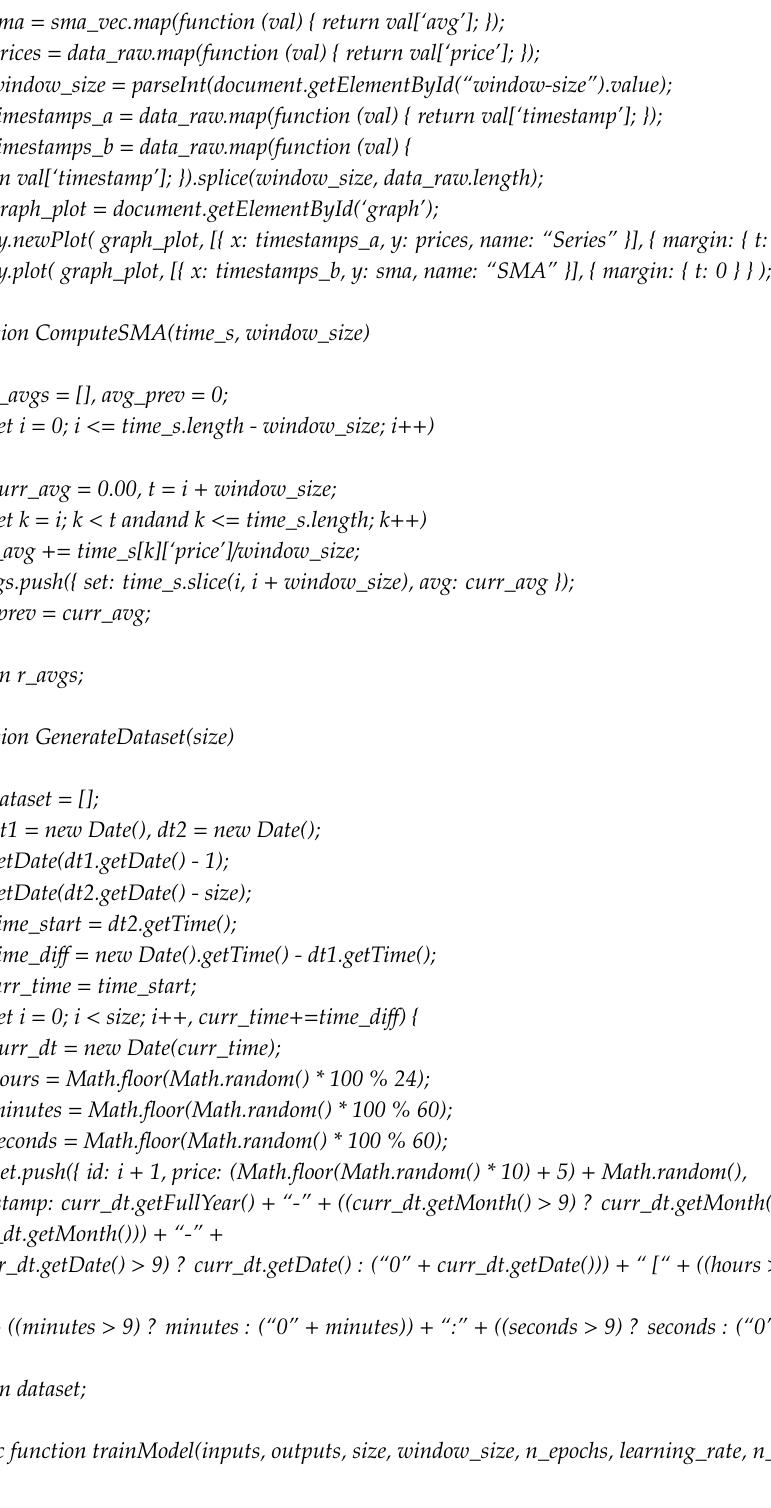
Plotly.newPlot( graph_plot, [{ x: timestamps, y: prices, name: “Stocks Prices” }], { margin: { t: 0 } }